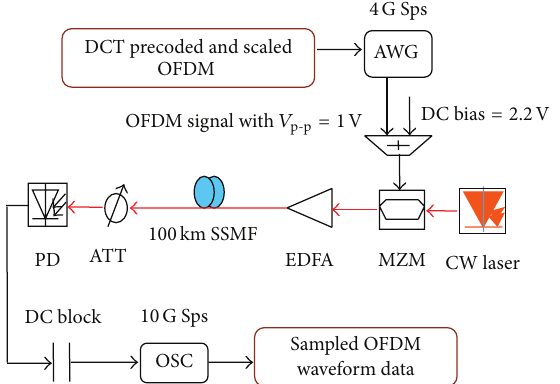
Figure5:Experimentalsetup(EDFA:erbium-dopedfiberamplifier;